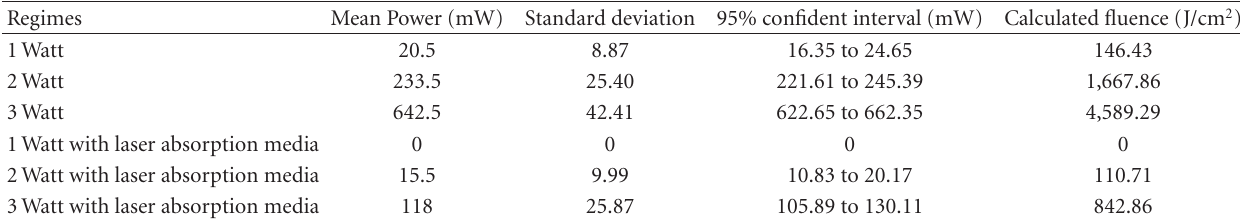
Table 1: The actual powers of CO 2 laser measured by the optical power meter. Regimes